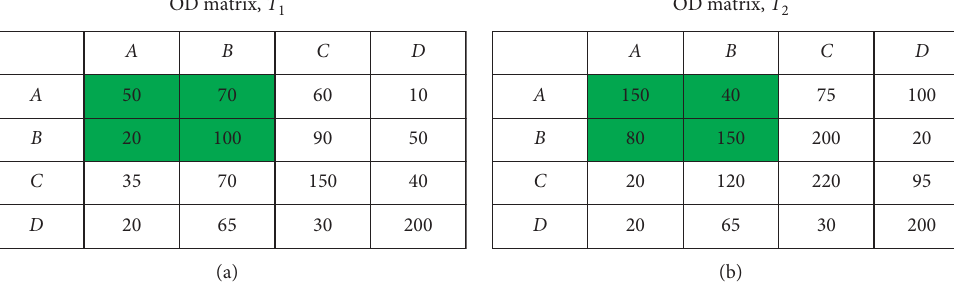
Figure 3: A sample of a local window to calculate